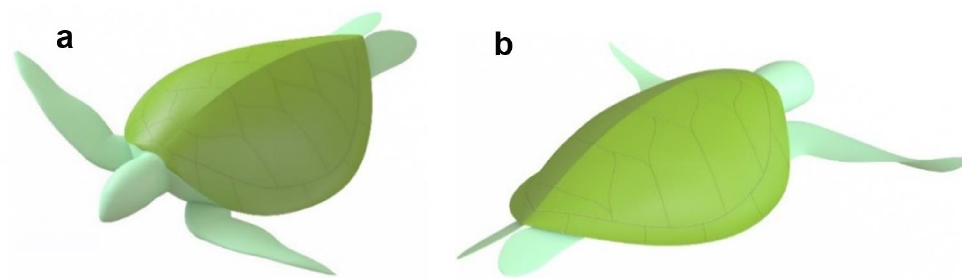
Figure 1. Three-dimensional model of a green sea turtle ( Chelonia mydas ) displaying various levels of wing twist of the pectoral wing. ( a ) Model showing upstroke with 28° degrees of wing twist. ( b ) of wing twist of the pectoral wing. ( a ) Model showing upstroke with 28 ◦ degrees of wing twist. Model showing downstroke with − 72° of wing twist [16] . ( b ) Model showing downstroke with − 72 ◦ of wing twist